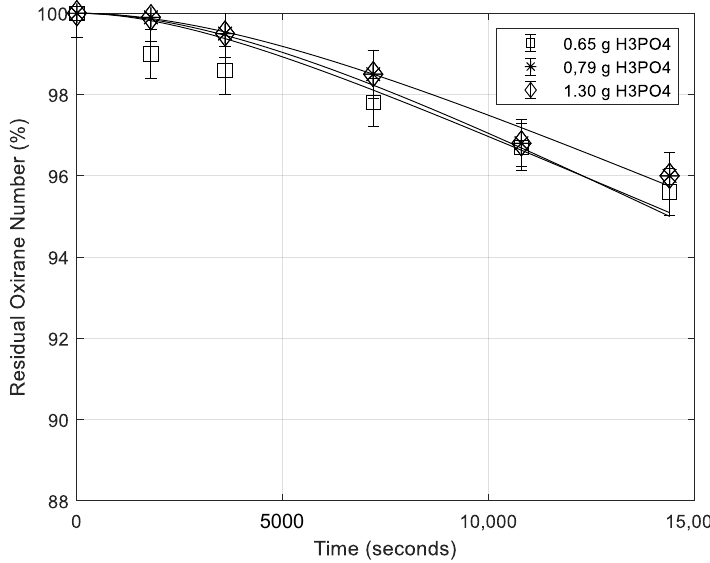
Figure 6. Residual oxirane number profiles for different contents of H 3 PO 4 . All the other conditions are the same (temperature 70 °C; rate of agitation 500 rpm; mass of formic acid 5.16 g). Points are experimental data lines that are calculated with the developed model.